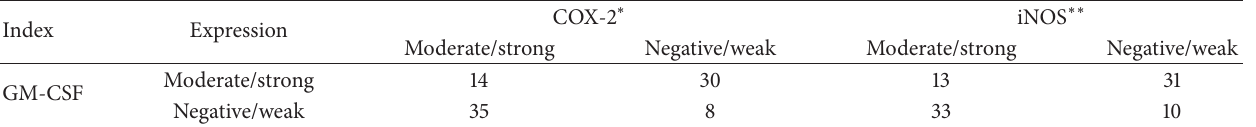
Table 3: Correlation between the expression of GM-CSF and COX-2 or iNOS in cervical cancer